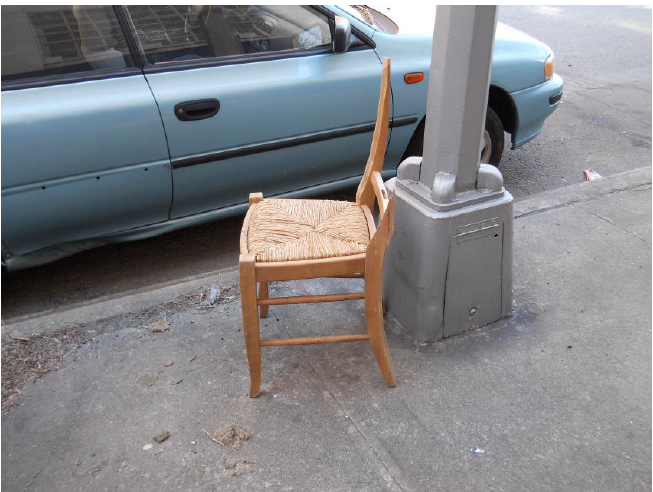
Figure 4. The broken chair.